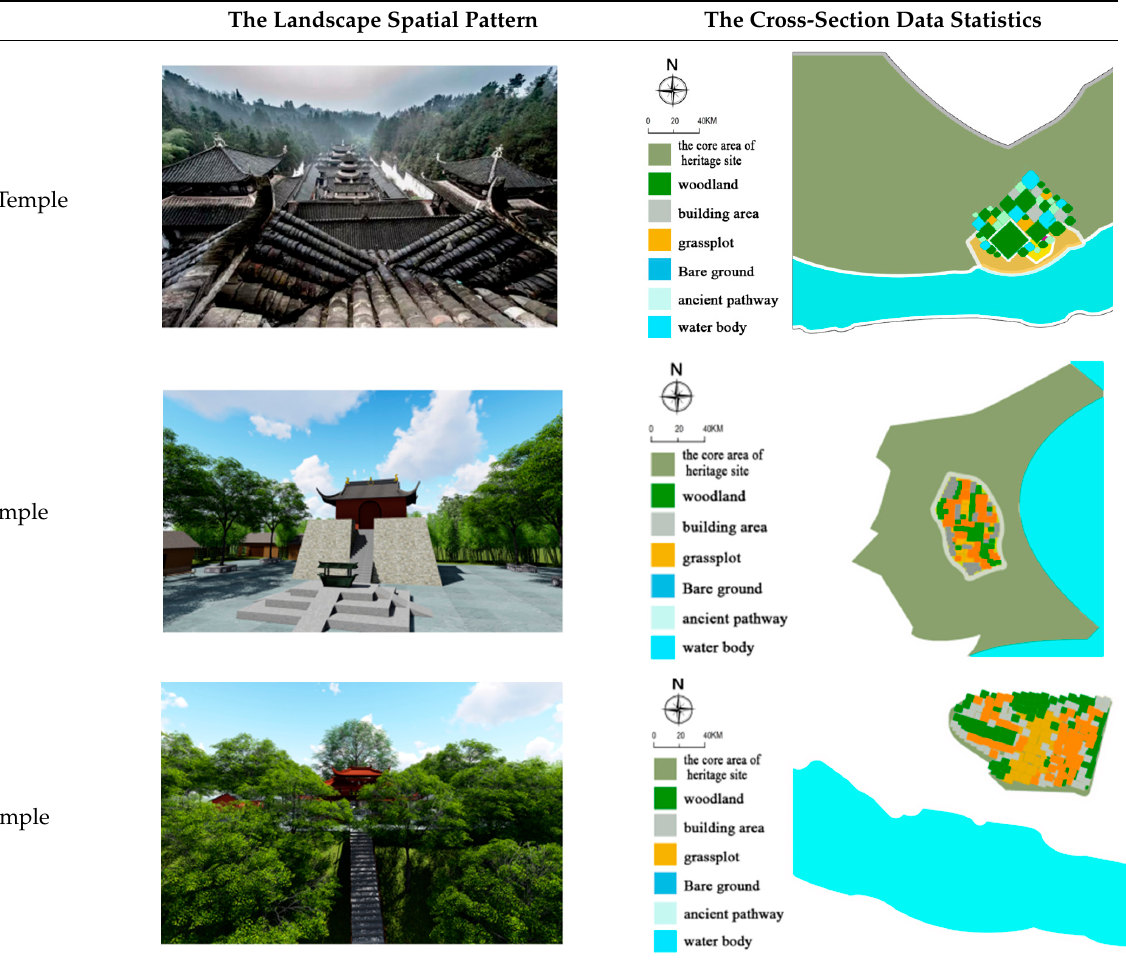
Table 2. Cultural landscape pattern after the remediation design project. S/N The Landscape Spatial Pattern The Cross-Section Data Statistics